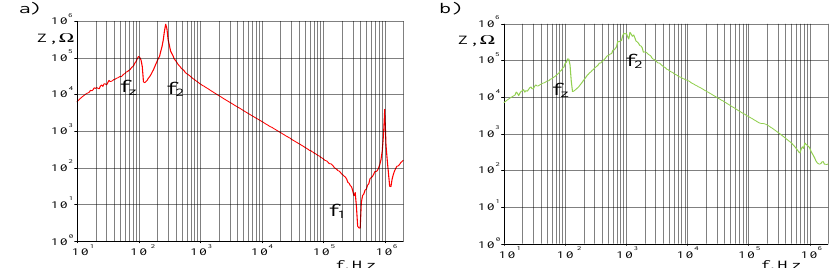
Figure 8. Relations Z = g (f) of a single-phase experimental system with a vacuum circuit breaker wb (Figure 3): ( a )—system: vacuum circuit breaker wb connected to the transformer with 85 m long cable line lc, ( b )—system: vacuum circuit breaker wb connected to the transformer with 2 m long cable line